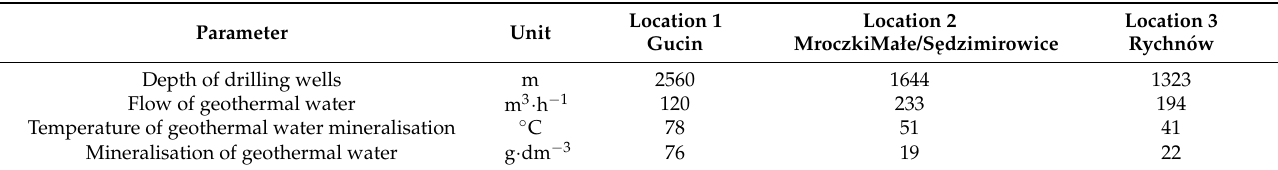
Table 7. Main characteristics of the selected location.